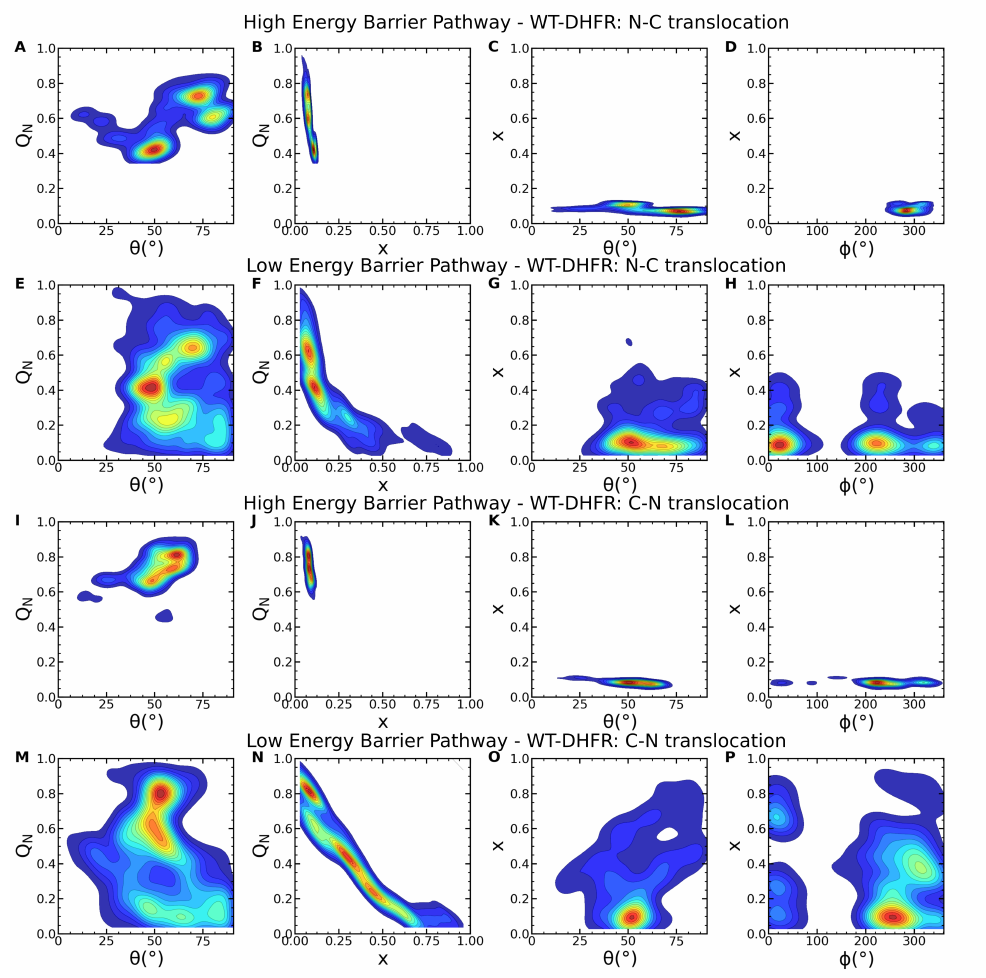
Figure 6. Wild-type DHFR substrate orientation at the ClpY pore lumen in unfolding and translocation pathways. Probability density maps of the ( A ) fraction of native contacts Q N vs. polar angle θ and ( B ) translocation fraction x; ( C ) translocation fraction vs. polar and azimuthal ( φ ) angles in N-C translocation in the high-energy barrier pathway. ( E – H ) Same as in ( A – D ) in the low-energy barrier pathway. ( I – P ) Same as in ( A – H ) in C-N